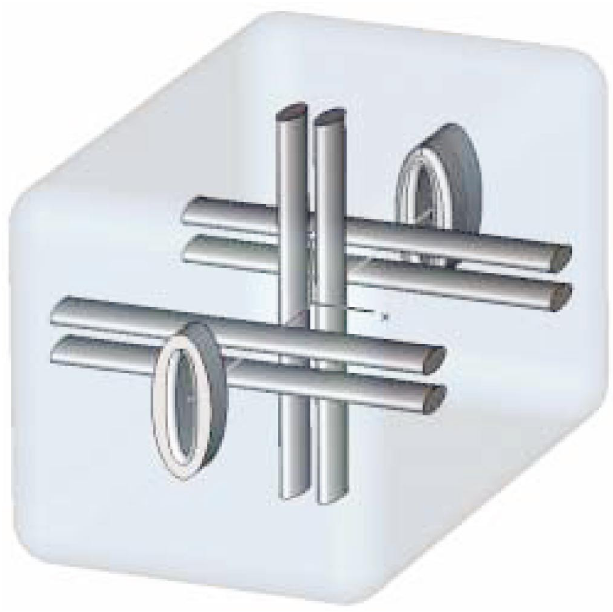
FIG. 4. (Color) Slot resonator in 3D.